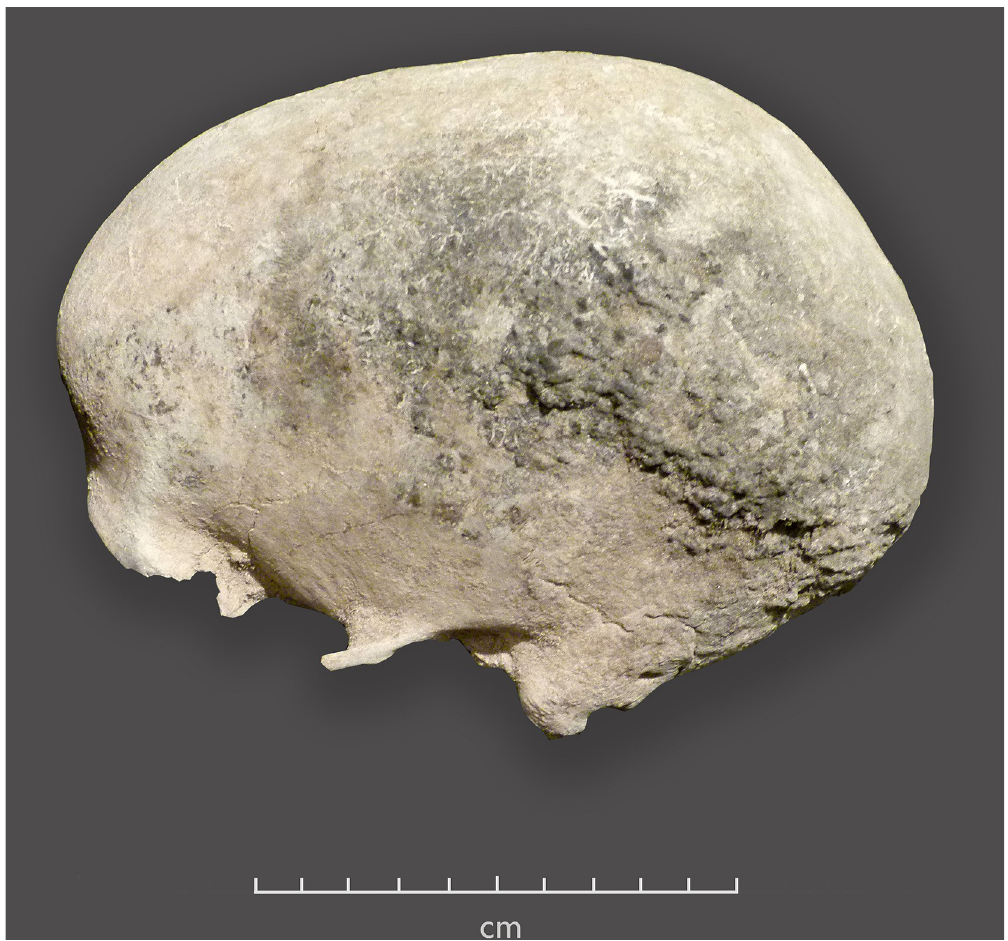
Fig 4. Left side of cranial vault, Upper Burial, SAM-AP 6420, showing possible hair in the area that would have been covered by a headband. can be traced from a point of impact on the lower right half of the occipital bone (Fig 5A). The cracks radiate anteriorly (through the parietal, toward the frontal) and inferiorly (reaching the foramen magnum and proceeding through the basi-occiput (cranial base) (Fig 5B). Images from a CT scan of the skull (120 kV, 2550mAs, slice thickness 0.9mm) shows that the break continued, cleaving the sella turcica (body of the sphenoid) (Fig 6). A small fracture radiates laterally from the foramen magnum (Fig 5B). This is consistent with the distribution of force from the main fracture when it reached the foramen magnum [as per 67]. The cracks in the atlas vertebra and the front of the jaw (Fig 5C and 5D) could result from a blow abruptly forc- ing the skull forward and down, with the chin hitting the ground hard, or they could reflect a second blow. Anterior fractures of the atlas can be the result of hyperextension of the head and neck [25]. Such extensive damage could result from a fall from a significant height, with the back of the head landing on a protruding rock, the body then falling forward. The pattern and extent of damage could also be interpreted as evidence of a powerful blow that knocked the woman down, face forward. In the context of a mostly flat landscape with no rocky outcrops nearby and a group burial, interpersonal violence is the more parsimonious interpretation.